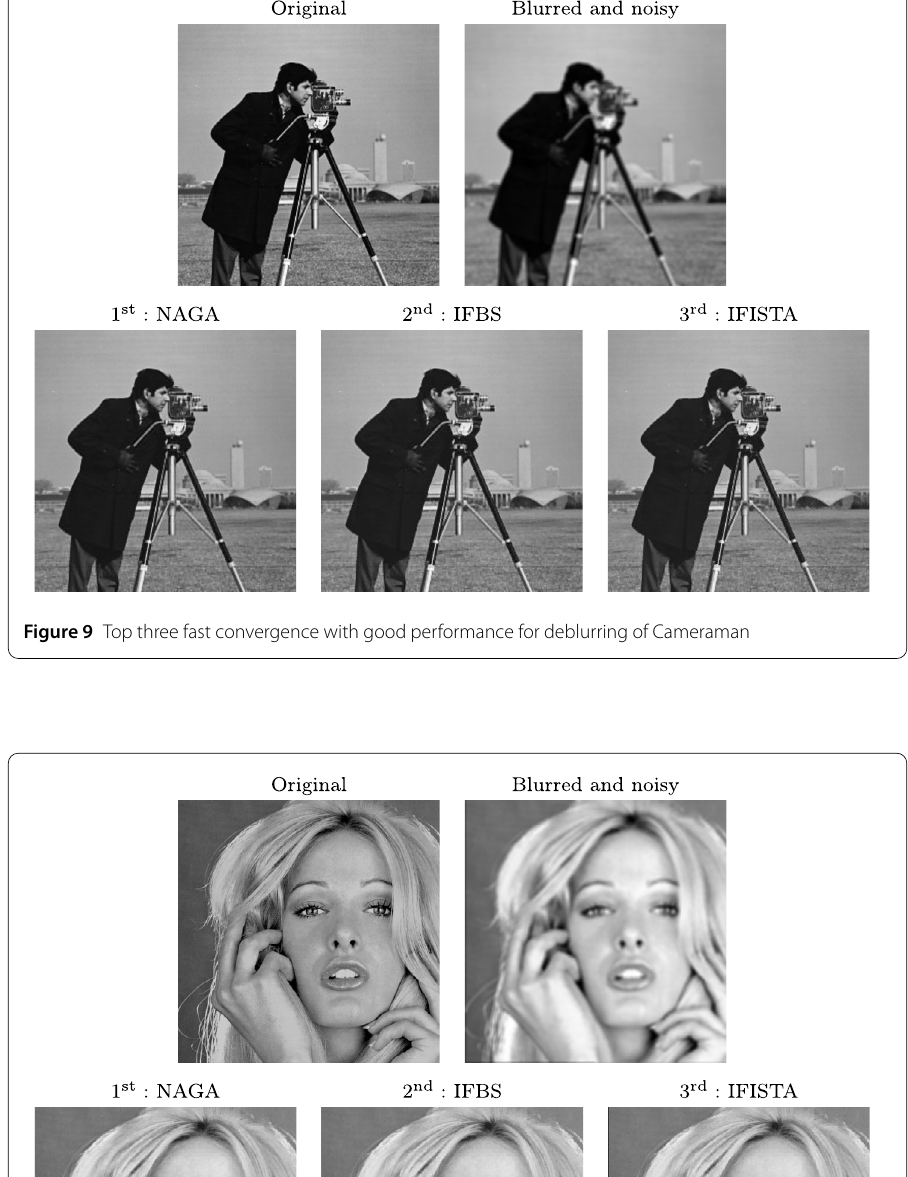
gramming techniques [36] and setting all parameters to their high performance, we obtain the following